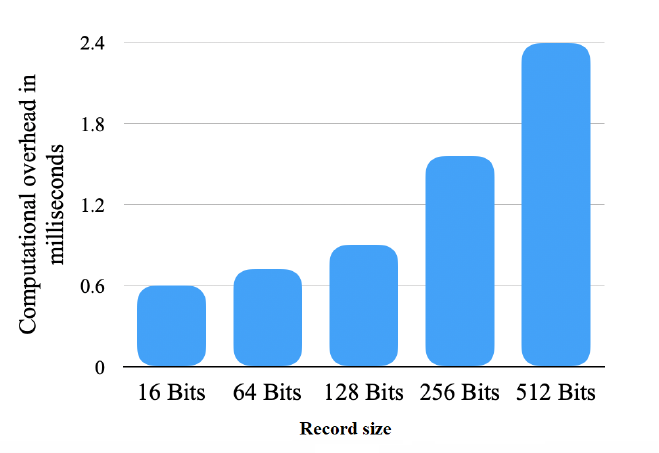
Figure 5. Encryption algorithms’ computational time in milliseconds with different record sizes. We vary the record size (16 bits, 64 bits, 128 bits, 256 bits, and 512 bits) and measure the time of encrypting and uploading the record to the blockchain. For each record size, we conduct the experiment 5 times and take the average.